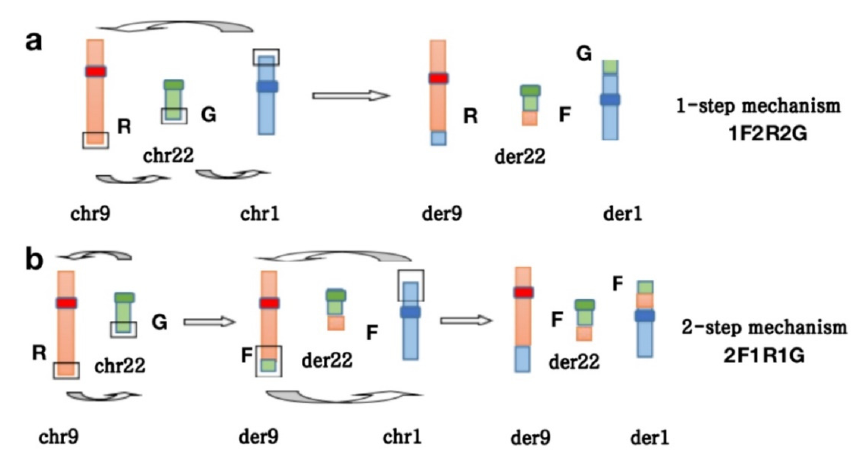
indicates chromosome; der indicates derivative chromosome). ( a ) One-step mechanism (1F2R2G: 1 fusion signal on der22, 2 red signals on der9 and normal chr9, 2 green signals on der1 and normal chr22). ( b ) Two -step mechanism (2F1R1G: 2 fusion signals on der22 and der1, 1 red signal on normal chr9, 1 green signal on normal